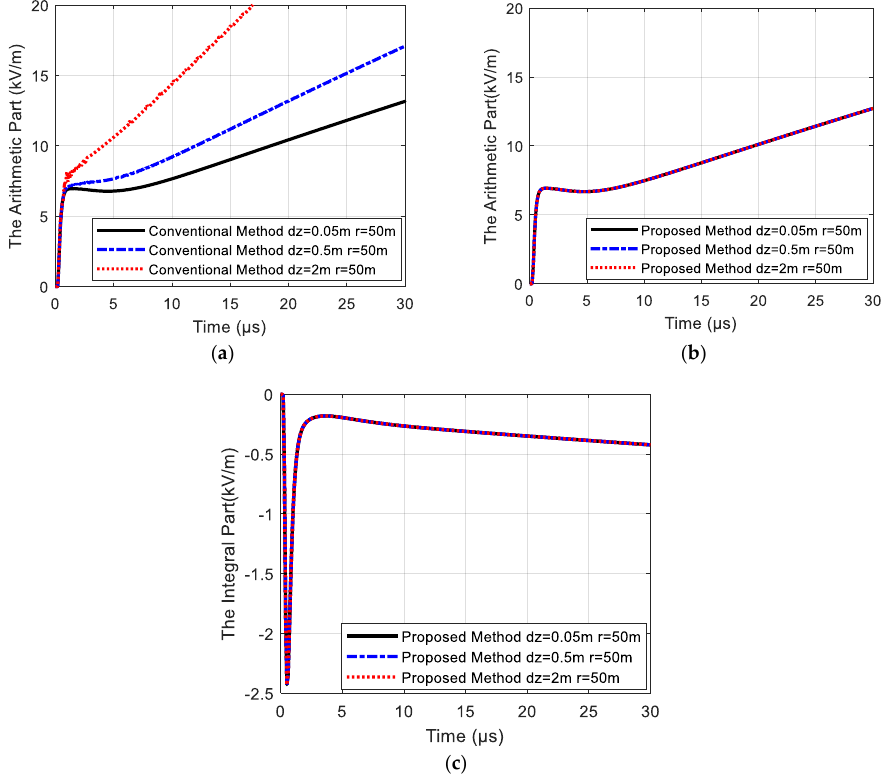
Figure 4. The two parts of the horizontal electric field at the observation point: ( a ) the arithmetic parts calculated by the conventional method; ( b ) the arithmetic parts calculated by the proposed method; ( c ) the integral part calculated by the proposed method.